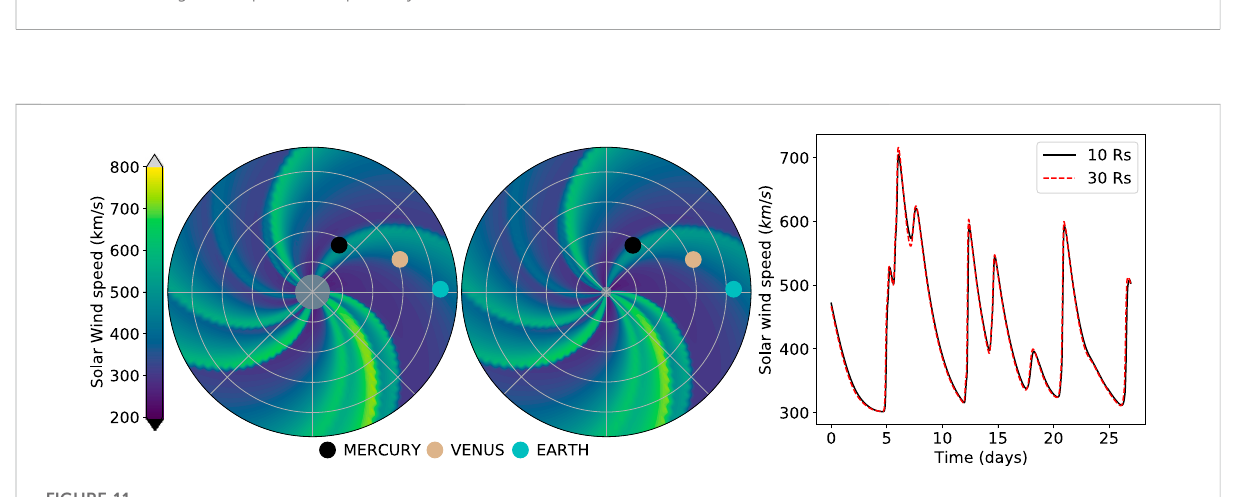
FIGURE 11 (Left) A snapshot of the HUXt simulation of Carrington rotation 2254 initialised at 30 R ⊙ . (Middle) A snapshot of a HUXt simulation of Carrington rotation2254wheretheinnerboundaryconditionhasbeenbackmappedto10 R ⊙ .(Right)TimeseriesofthesolarwindspeedatEarthfromtheHUXt simulations initialised at 30 R ⊙ (red line) and 10 R ⊙ (black line).